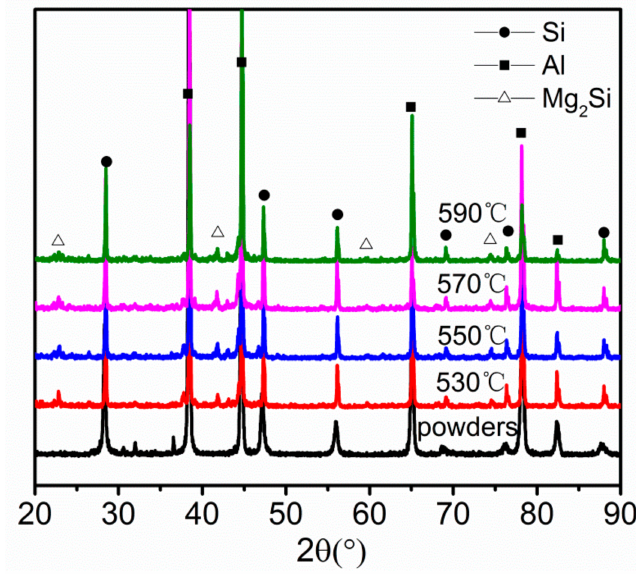
Figure 12. XRD patterns of alloy powders and sintered parts sintered at different